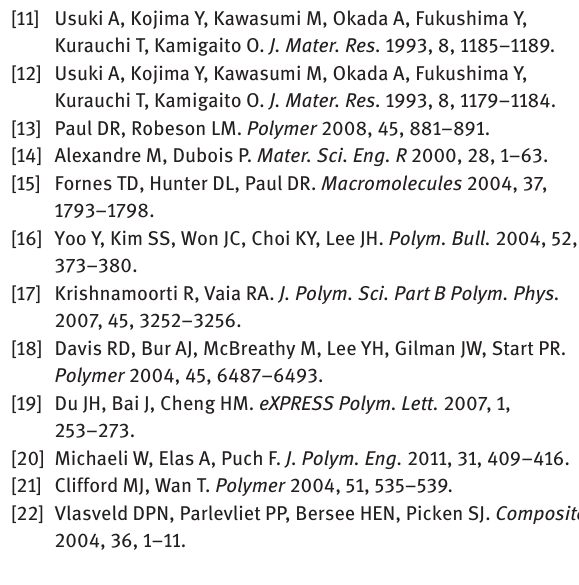
modulus and the tensile strength show good results at 30 kg/h and 500 min -1 , respectively. Thus, a throughput of 30 kg/h and a screw speed of 500 min -1 are the optimum compromise and are suggested for further trials. Even though the Young ’ s modulus and the tensile strength achieve the best results with a screw configuration intro- ducing a medium amount of shear energy, the screw con- figuration introducing the maximum amount of shear forces may be most suitable for compounding the short glass fiber-reinforced polypropylene-layered silicate com- posites because the notched impact strength tends to show the best results, and the NC is dispersed relatively well.